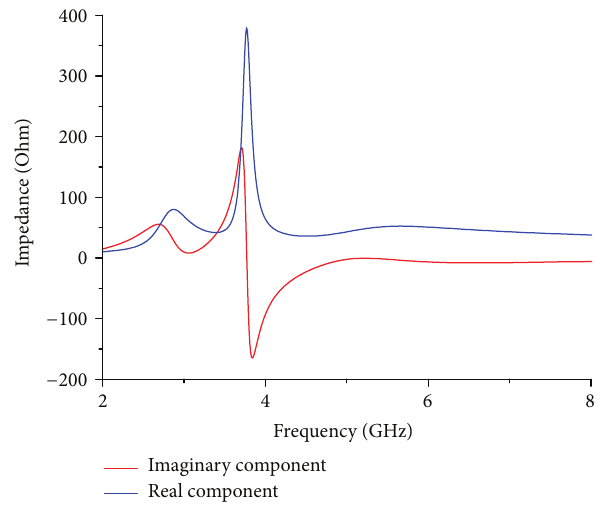
Figure 6: Impedance 𝑍 of the antenna versus frequency.